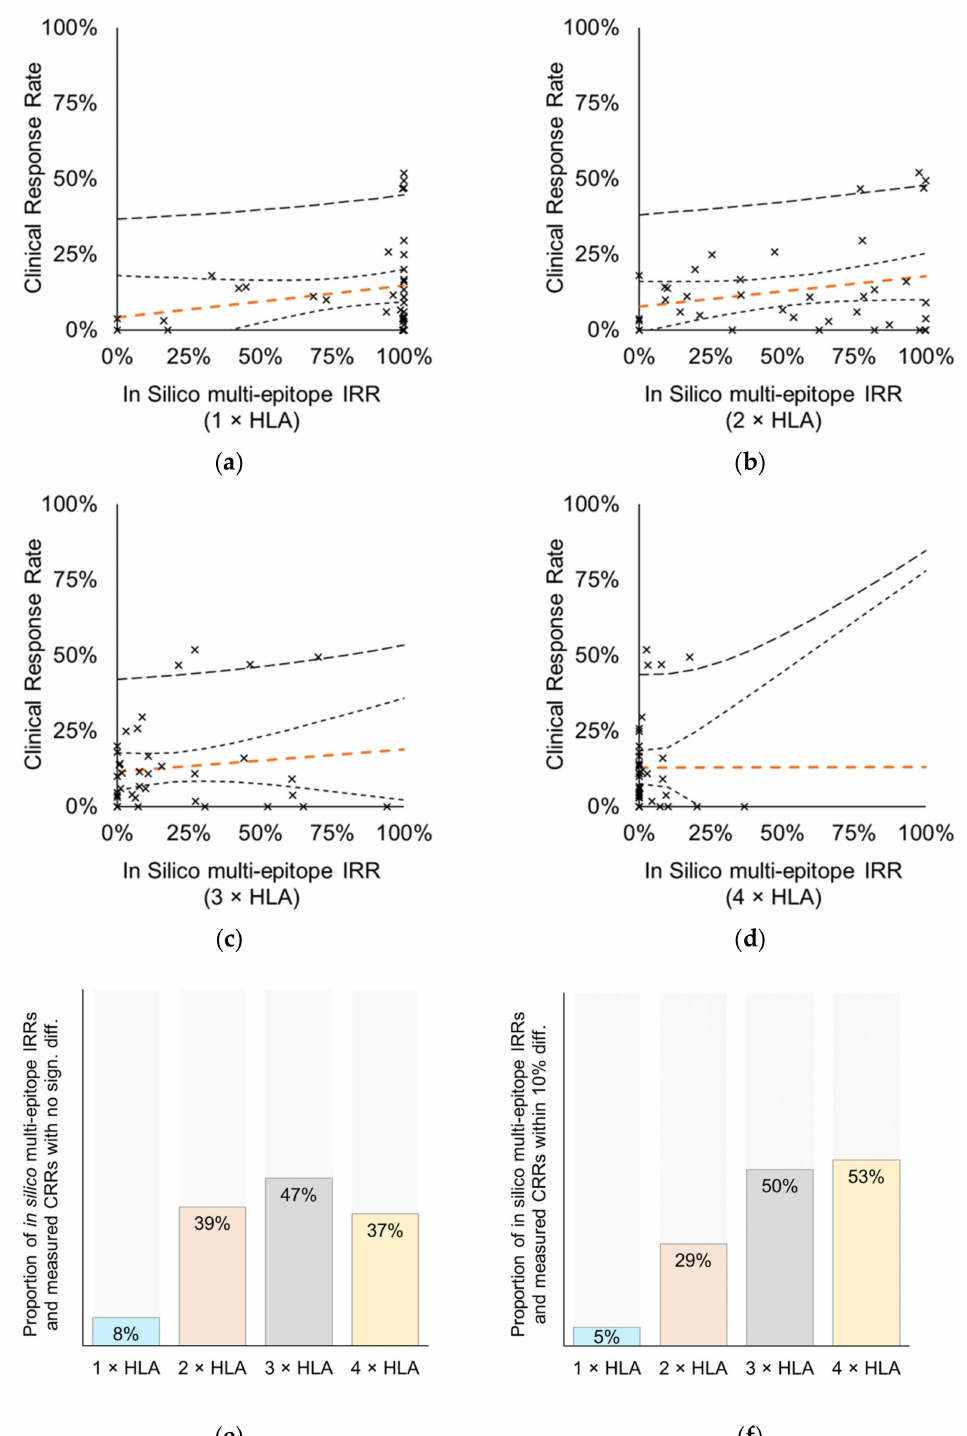
Figure 5. Correlation analysis between CRRs measured by CTs and in silico multi-epitope IRRs with cut-offs HLA ≥ 1, ≥ 2, ≥ 3, or ≥ 4 in the MP. Analysis included 49 CTs with 31 vaccines, total of 38 data points. Prediction of multi-epitope IRRs required the presence of at least two vaccine-specific epitopes that are ( a ) restricted to ≥ 1 autologous HLA class I allele ( r = 0.2233, p = 0.1777), ( b ) restricted to ≥ 2 autologous HLA class I alleles ( r = 0.2520, p = 0.1269), ( c ) restricted to ≥ 3 autologous HLA class I alleles ( r = 0.1253, p = 0.4536), ( d ) restricted to ≥ 4 autologous HLA class I alleles ( r = 0.0003, p = 0.9985) of the subjects in the MP, respectively. Orange dashed line: perpendicular trend line with 95% confidence interval band (95% prediction interval band is shown by thicker dashed line). ( e , f ) Pairwise Chi square analysis of measured CRRs and predicted multi-epitope IRRs; bars represent the proportion of the analyzed data pairs where difference was ( e ) not significant ( p > 0.05), or ( f ) within